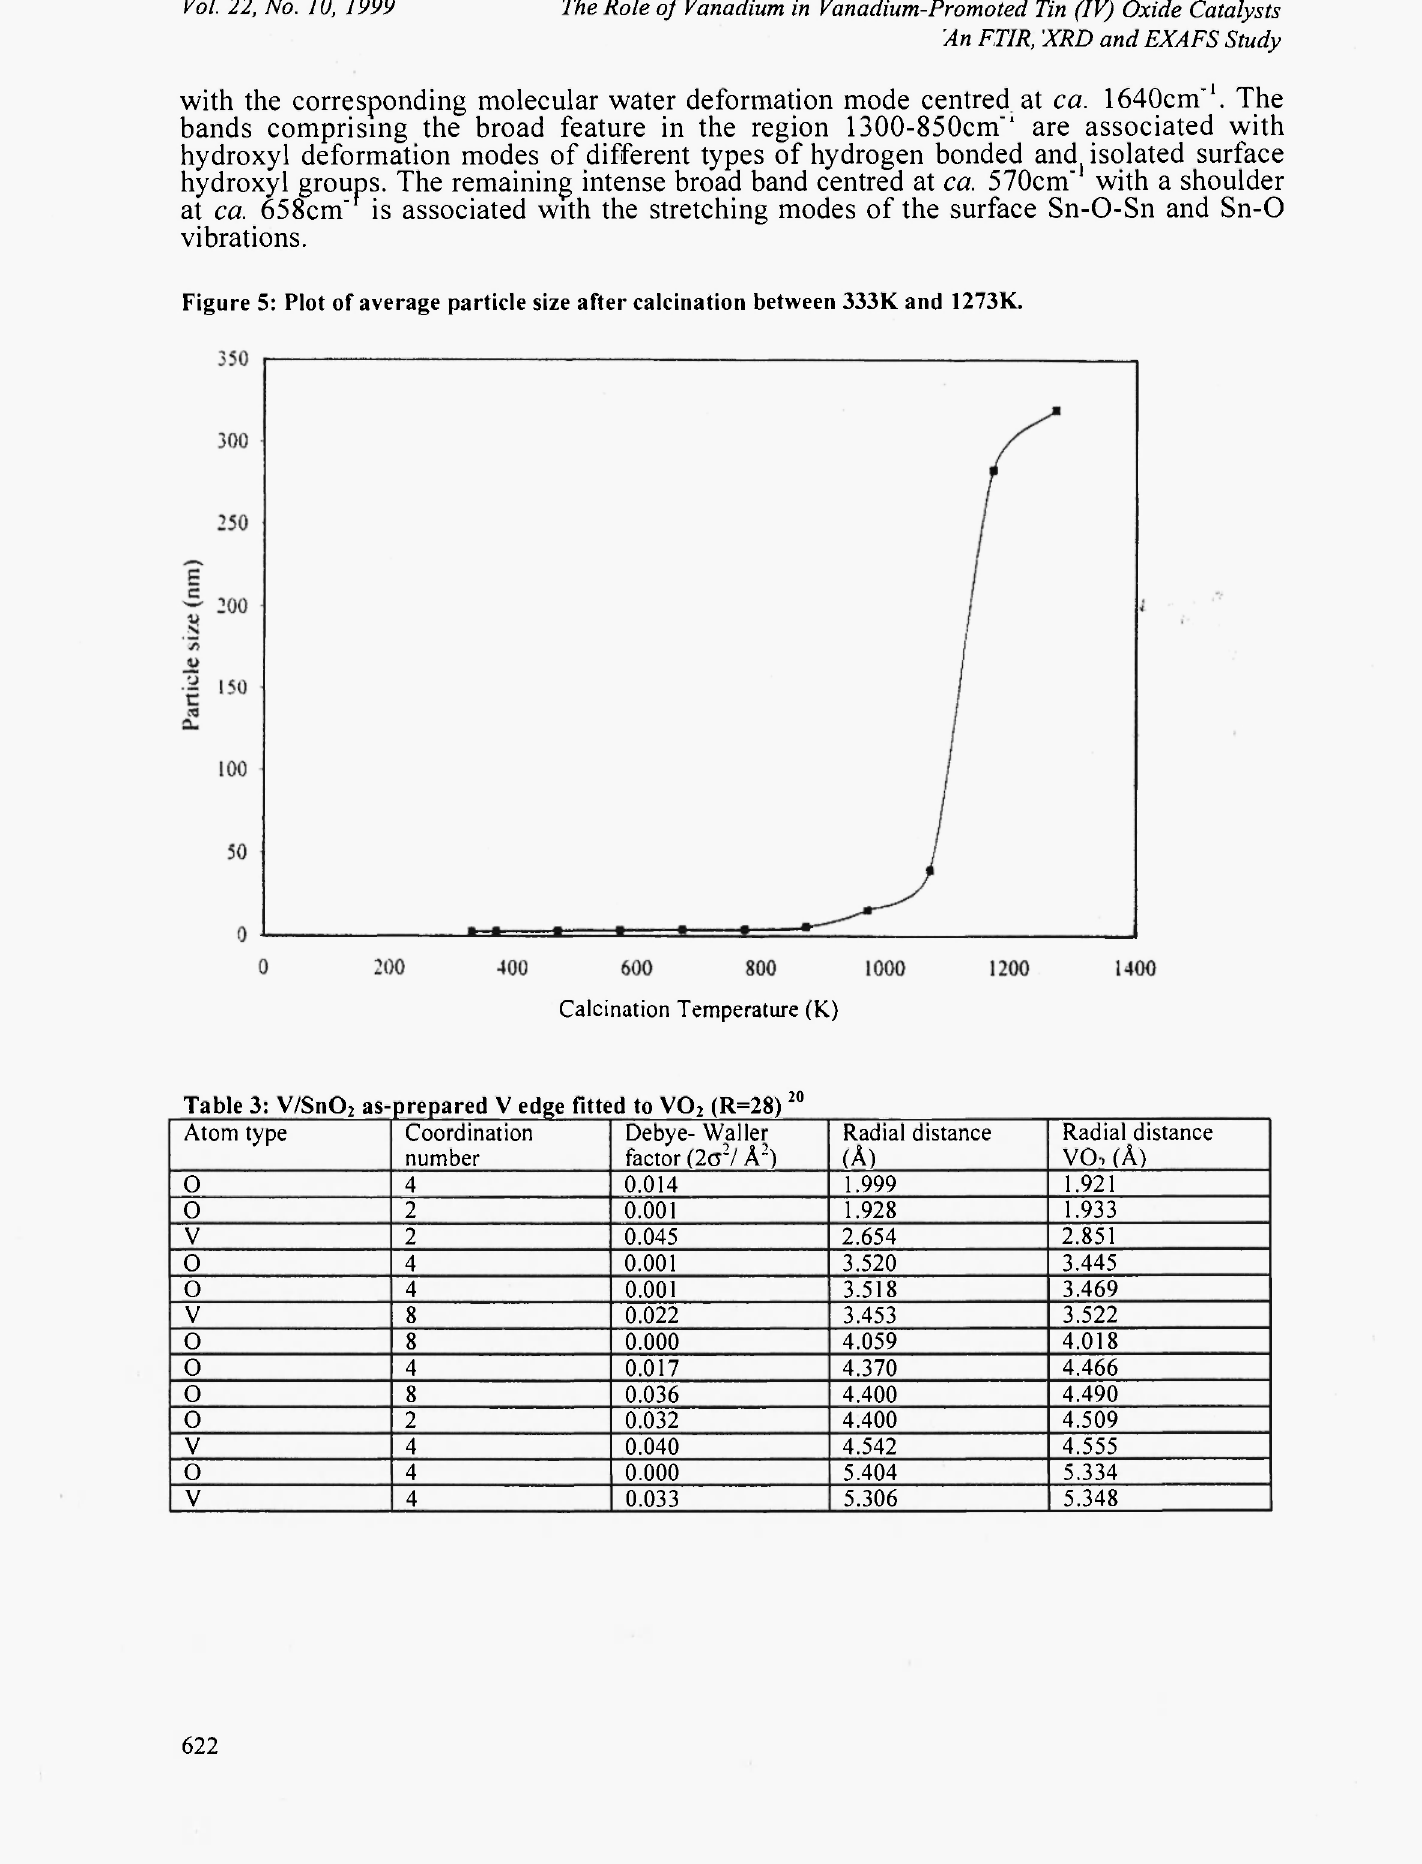
Table 3: V/SnQ 2 as-prepared V edge fitted to VQ 2 (R=28)